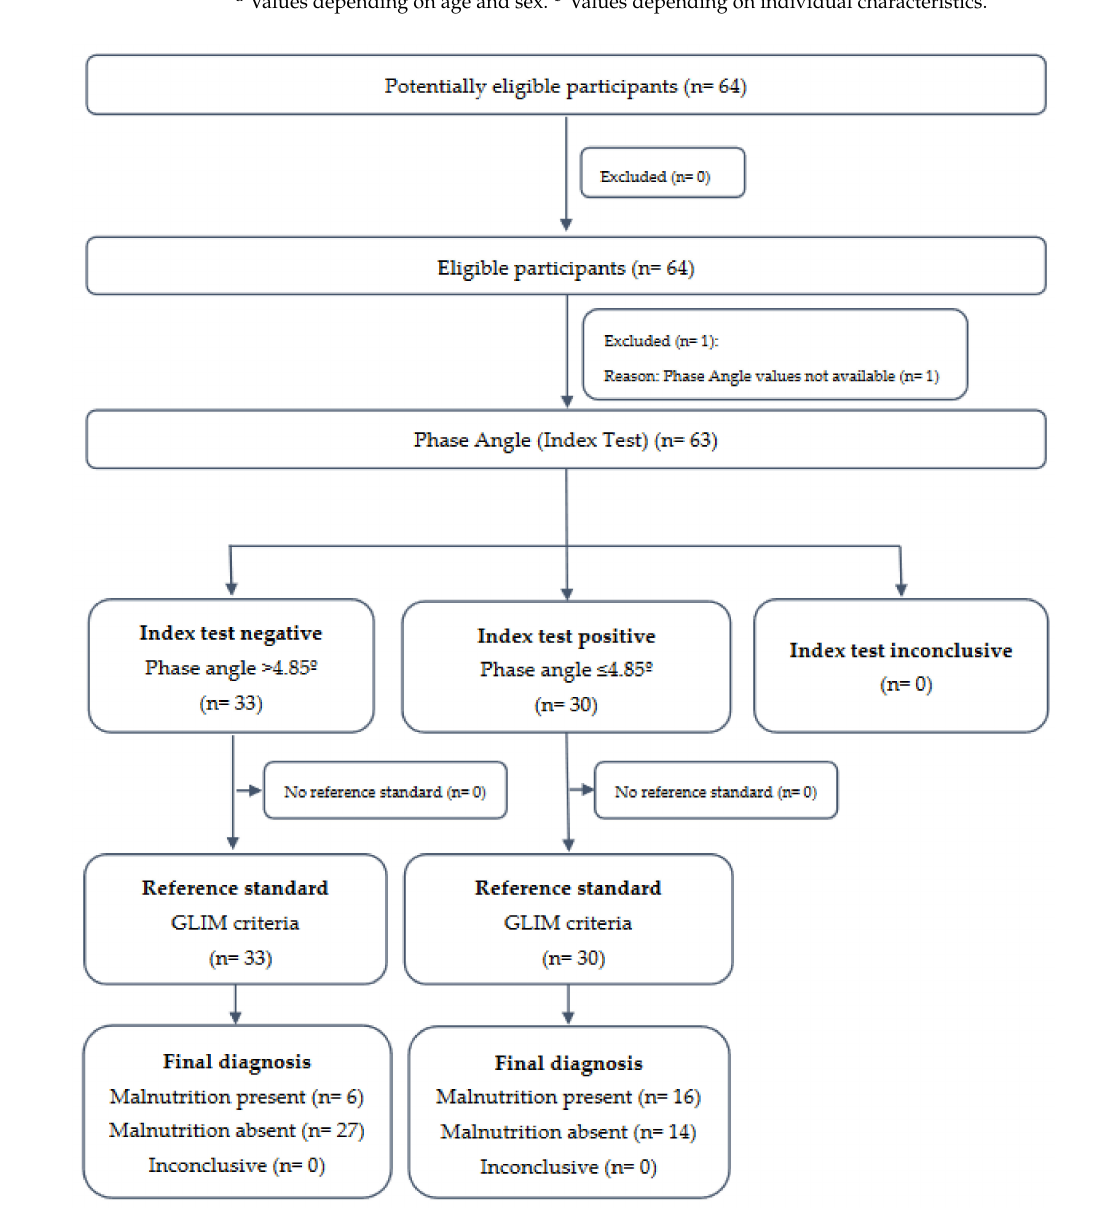
Figure 1. STARD diagram reporting flow of participants ( n = 64). Mean fat-free mass was within the normality range of the reference population [17]. All patients had increased percentages of body fat (mean 31.6 (SD 10.0) in men; 40.7 (SD